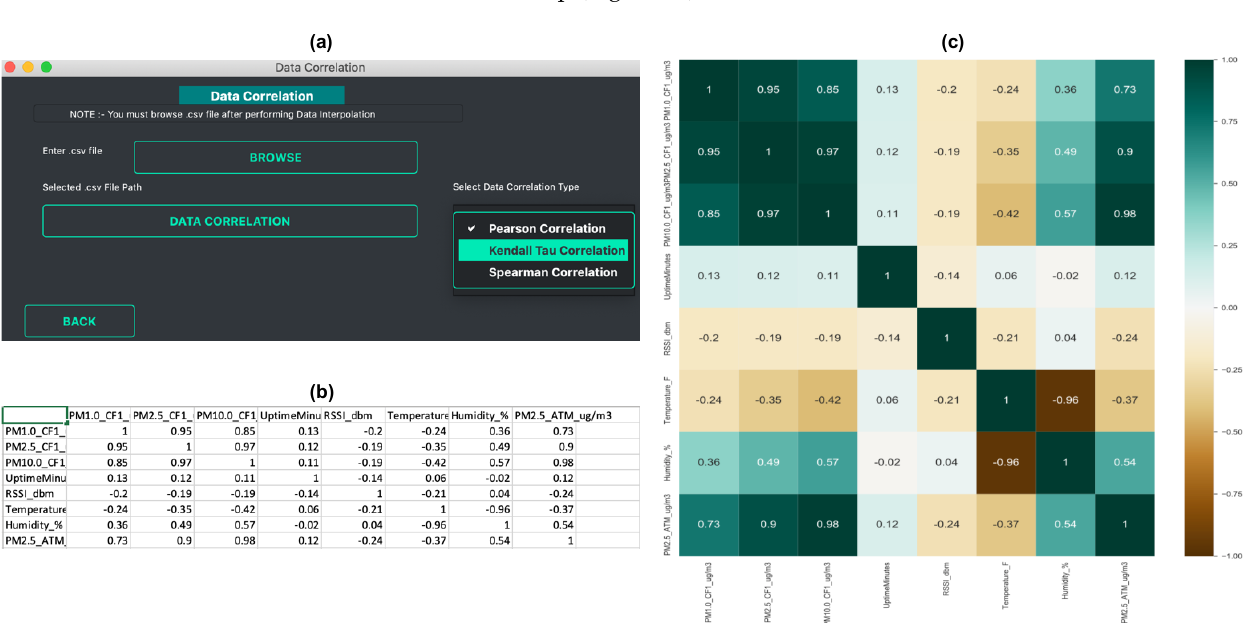
Figure 4. Data correlation example: ( a ) Snapshot of data correlation GUI, ( b ) output as a CSV file, and ( c ) correla- tion